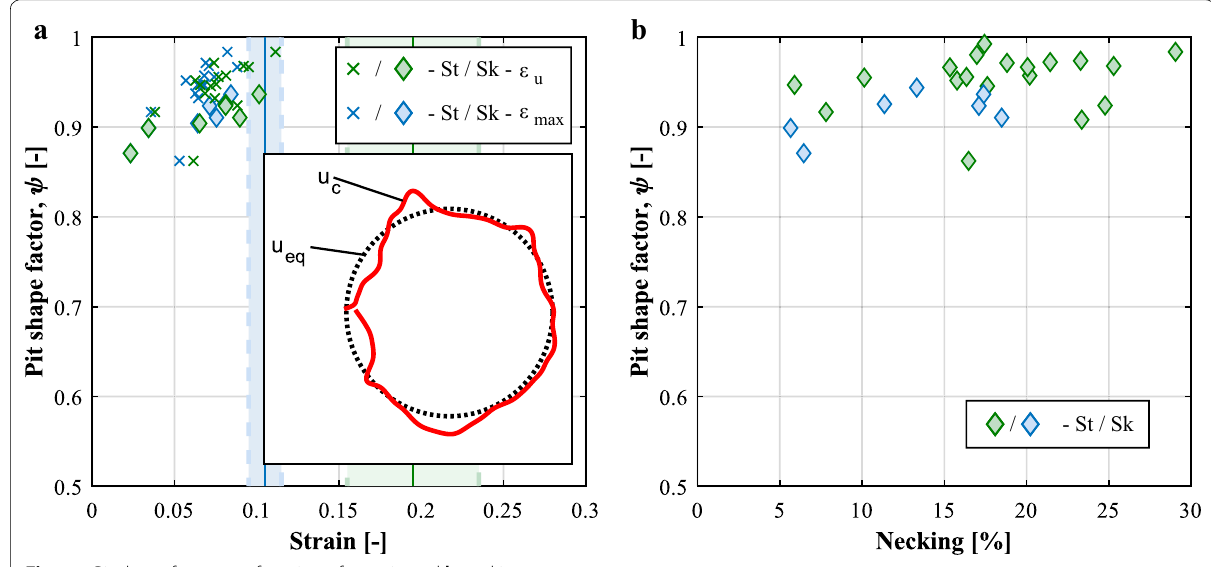
Fig. 17 Pit shape factor as a function of a strain and b